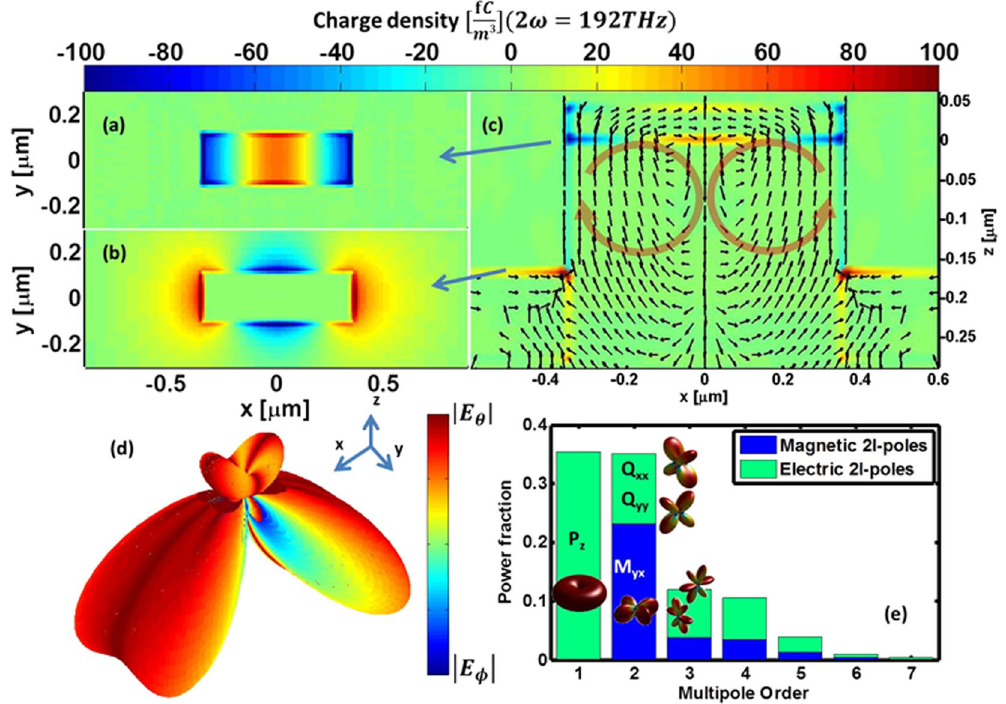
Figure 3. Isolated resonator nonlinear response. ( a–c ) Total charge density distributions oscillating at the SH frequency. ( a ) and ( b ) are XY plane slices where the z position is denoted by the blue arrows. ( c ) Slice position same as Fig. 2(c). The black arrows denote the direction of the total current density. The red circulating arrows highlight the current trends responsible for the lowest non-dipolar mode. ( d ) Far field radiation profile. The unit vectors are given for orientation. ( e ) Fraction of power radiated as a function of multipole order. The main contributing moments are explicitly named and their radiation pattern is schematically